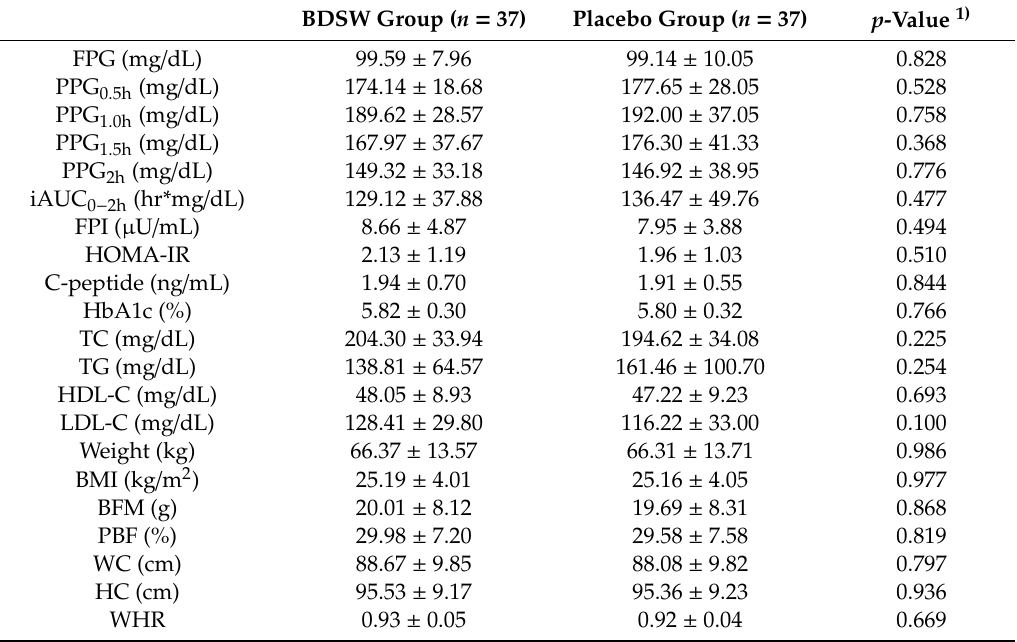
Table 3. Baseline of e ff ectiveness